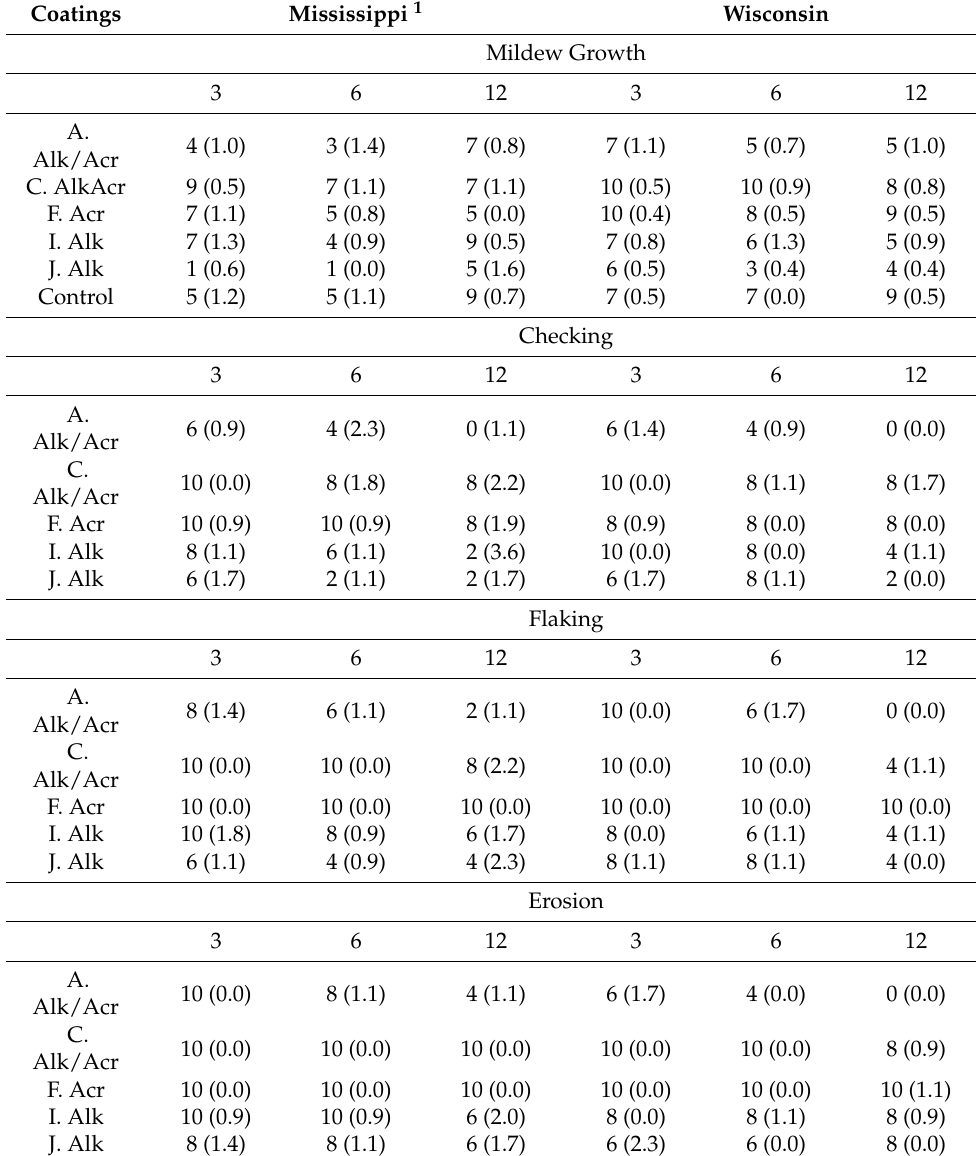
Table 3. Average visual rating for coatings after 3, 6 and 12 months of outdoor exposure in Mississippi and Wisconsin, reported as mean and standard deviation in